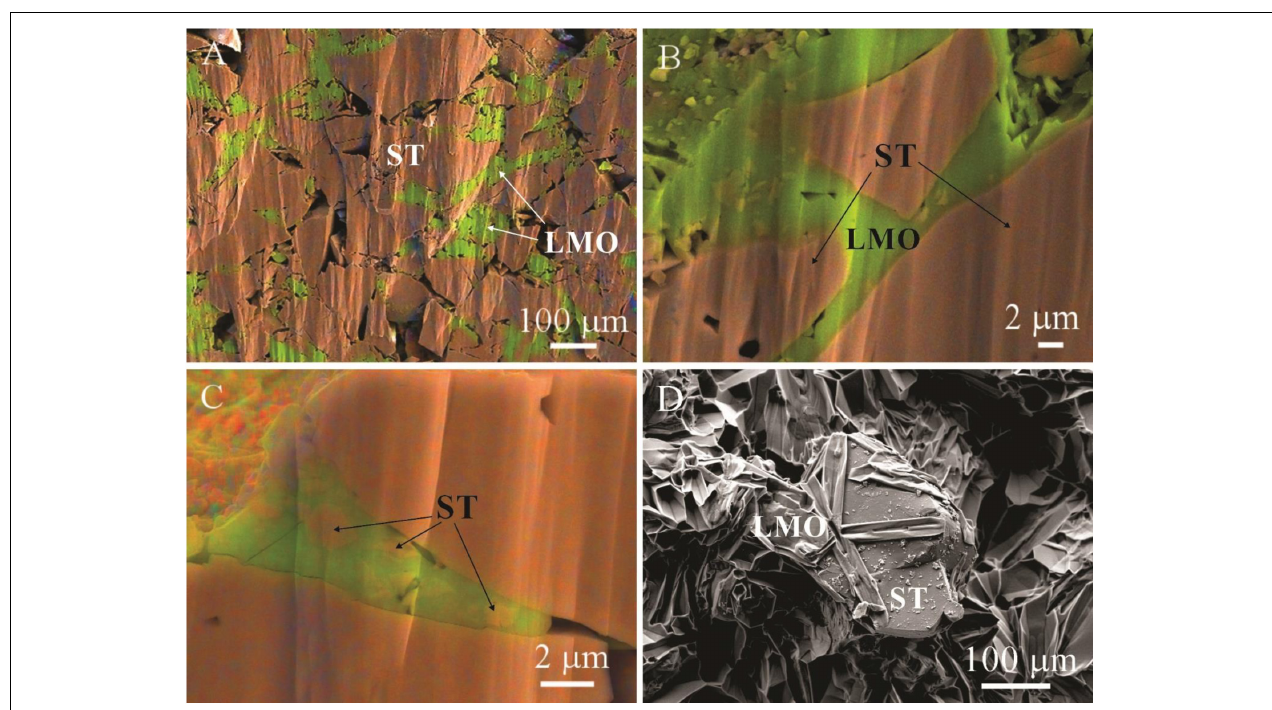
FIGURE 4 | EDS mappings of the cross section (A–C) . (B,C) Expanded view of the LMO-ST contact showing good adhesion and bonding of LMO (green color) on the surface of larger and smaller ST particles (orange color). (D) SEM micrograph of the surface of the prepared